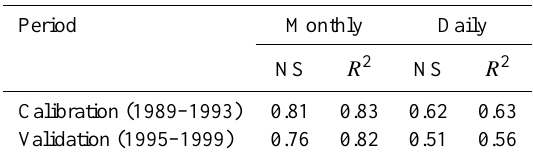
Table 4. Calibration (1989–1993) and validation (1995–1999) for the SWAT